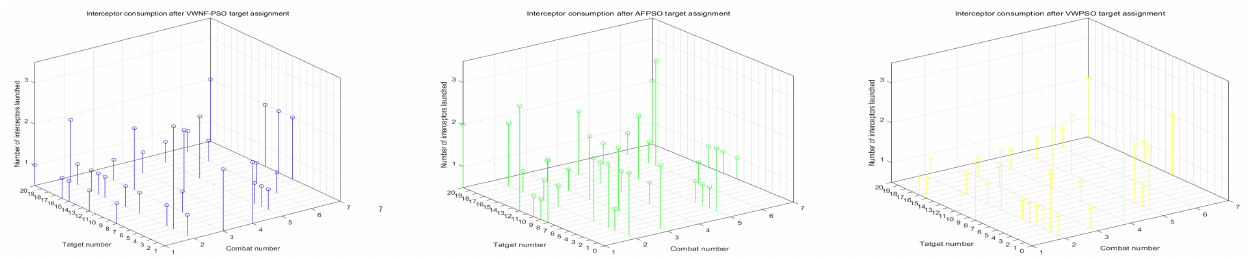
Figure 9. Number of interceptors consumed.